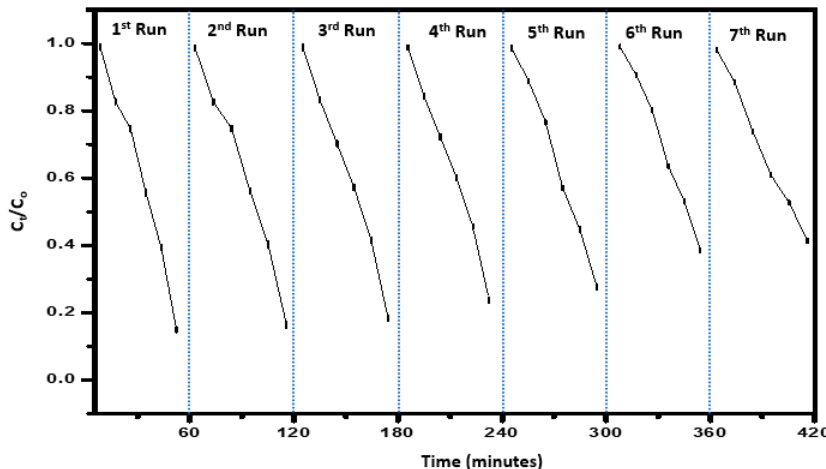
Figure 10. Recyclability experiments of the composite.